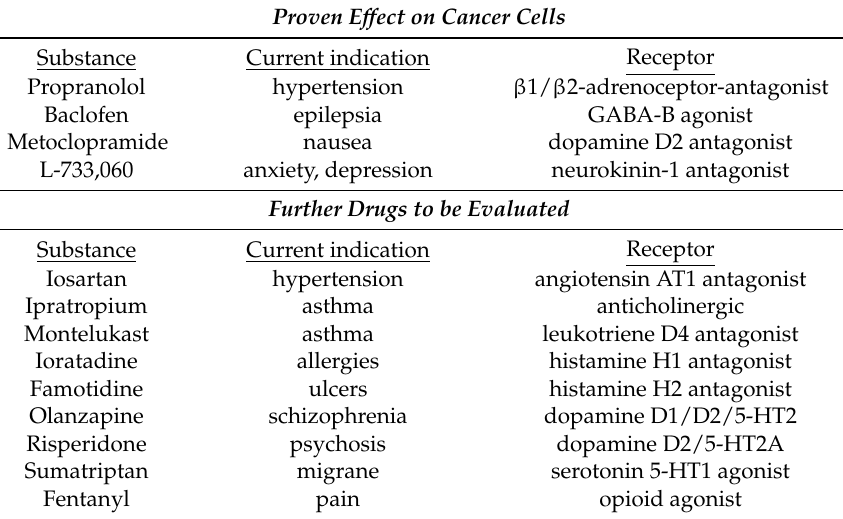
Table 1. Neurotransmitter agonists and